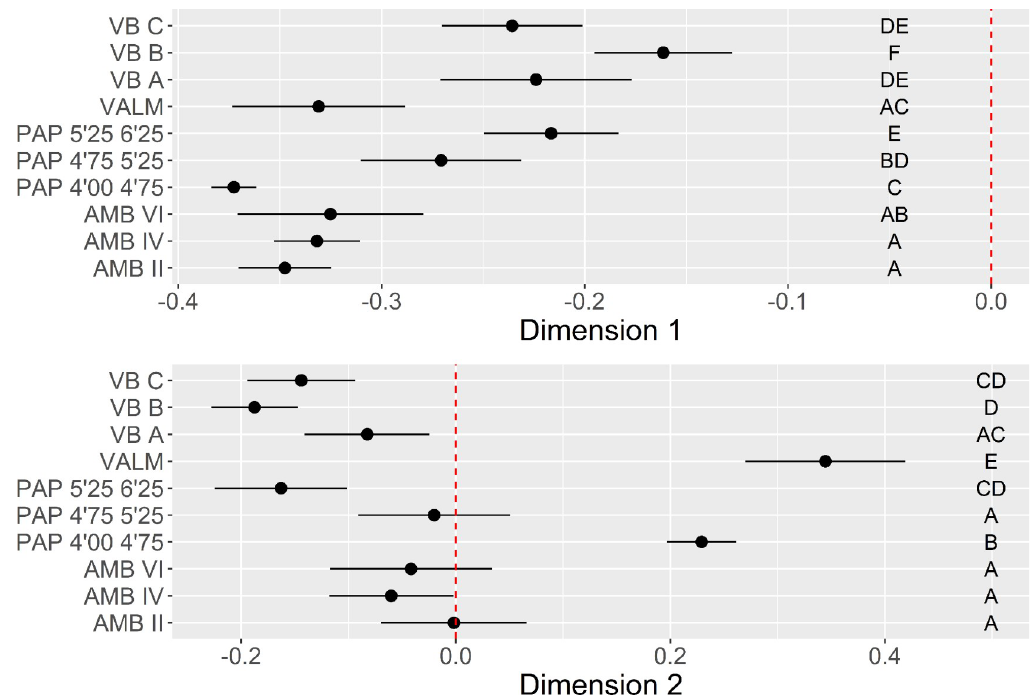
Fig 8. Direction of core exploitation multi-comparison bootstrap ANOVA. Error bars represent 95% confidence interval from the mean. Contexts sharing the same set of letters do not present statistically significant difference (p-value � 0.05).